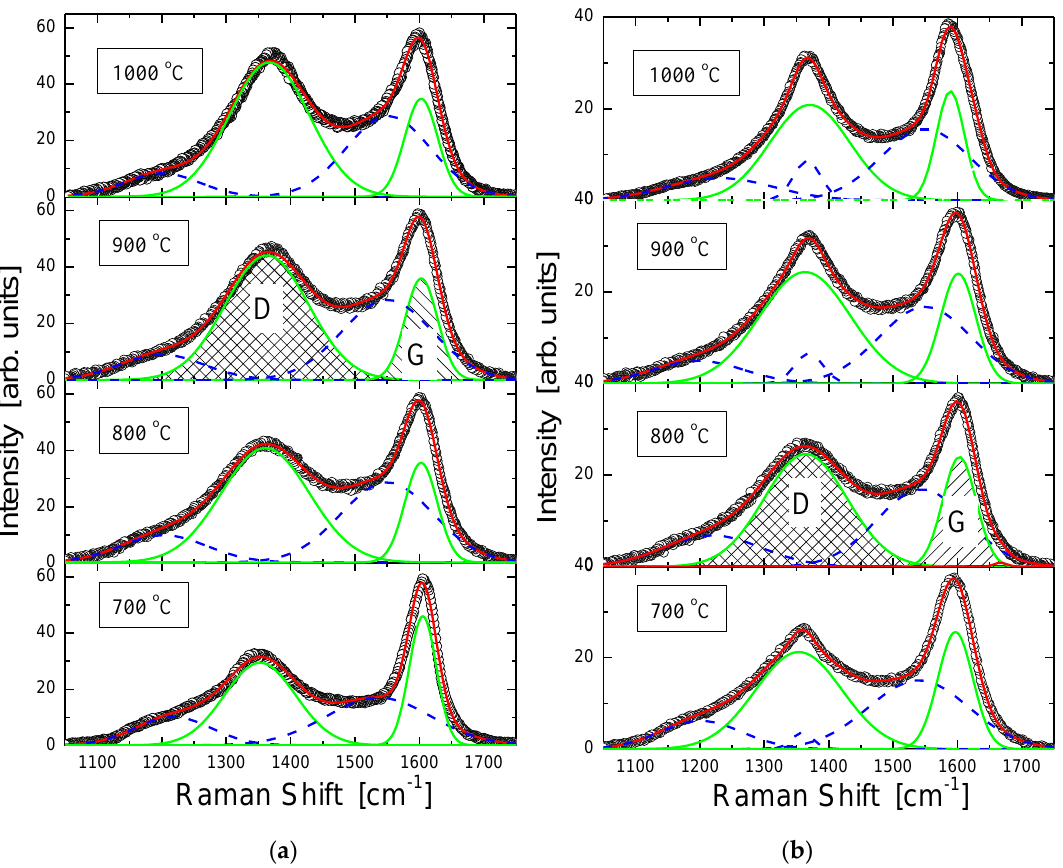
Figure 7. Gaussian line fitting of the Stokes-side Raman spectra of ( a ) C1-TS and ( b ) C2-Fe at various pyrolysis temperatures. The open circles correspond to the experimental points, while the thick line passing though the points is the best fit result.